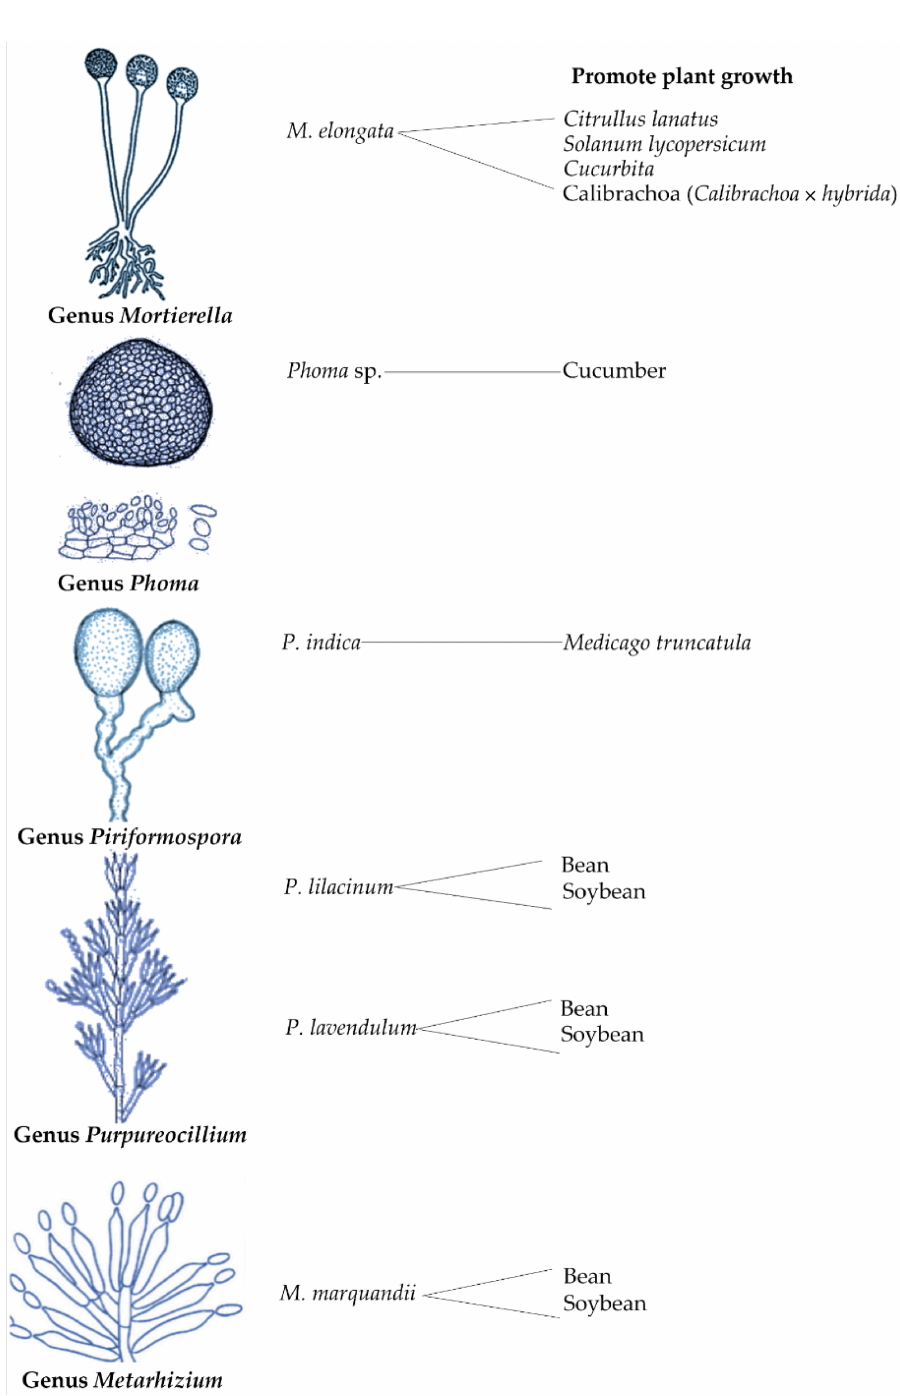
Figure 5. Species of the genera Purpureocillium , Metarhizium , Mortierella , Phoma , and Piriformospora used in the promotion of plant